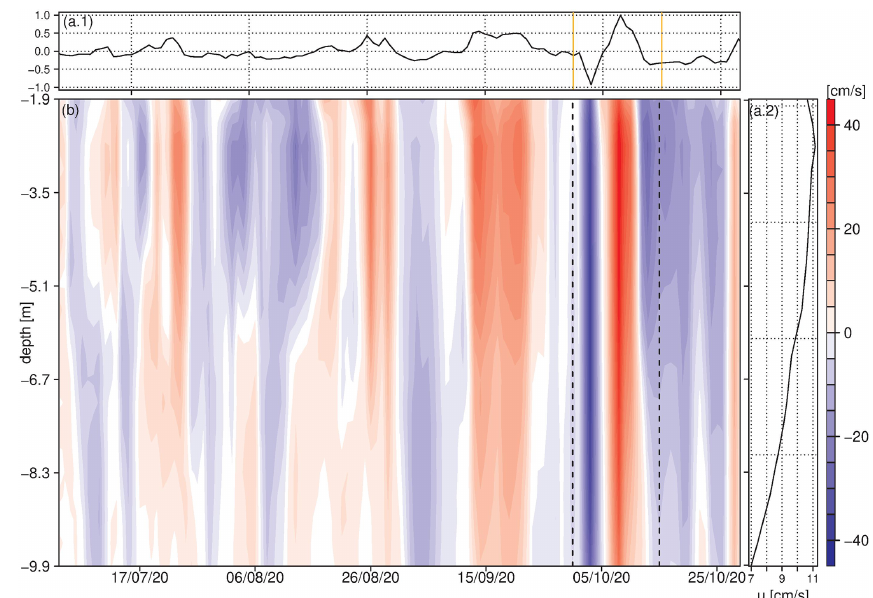
Figure 4. Mode 1 of the empirical orthogonal function (EOF) analysis for the ADCP alongshore currents: (a.1) temporal distribution and (a.2) spatial distribution. (b) Time–depth distribution of the alongshore current. The dates of the passage of storms Gamma and Delta are highlighted (dashed black and solid orange lines). Blue (red) colors represent a westward (eastward) flow. The date format is